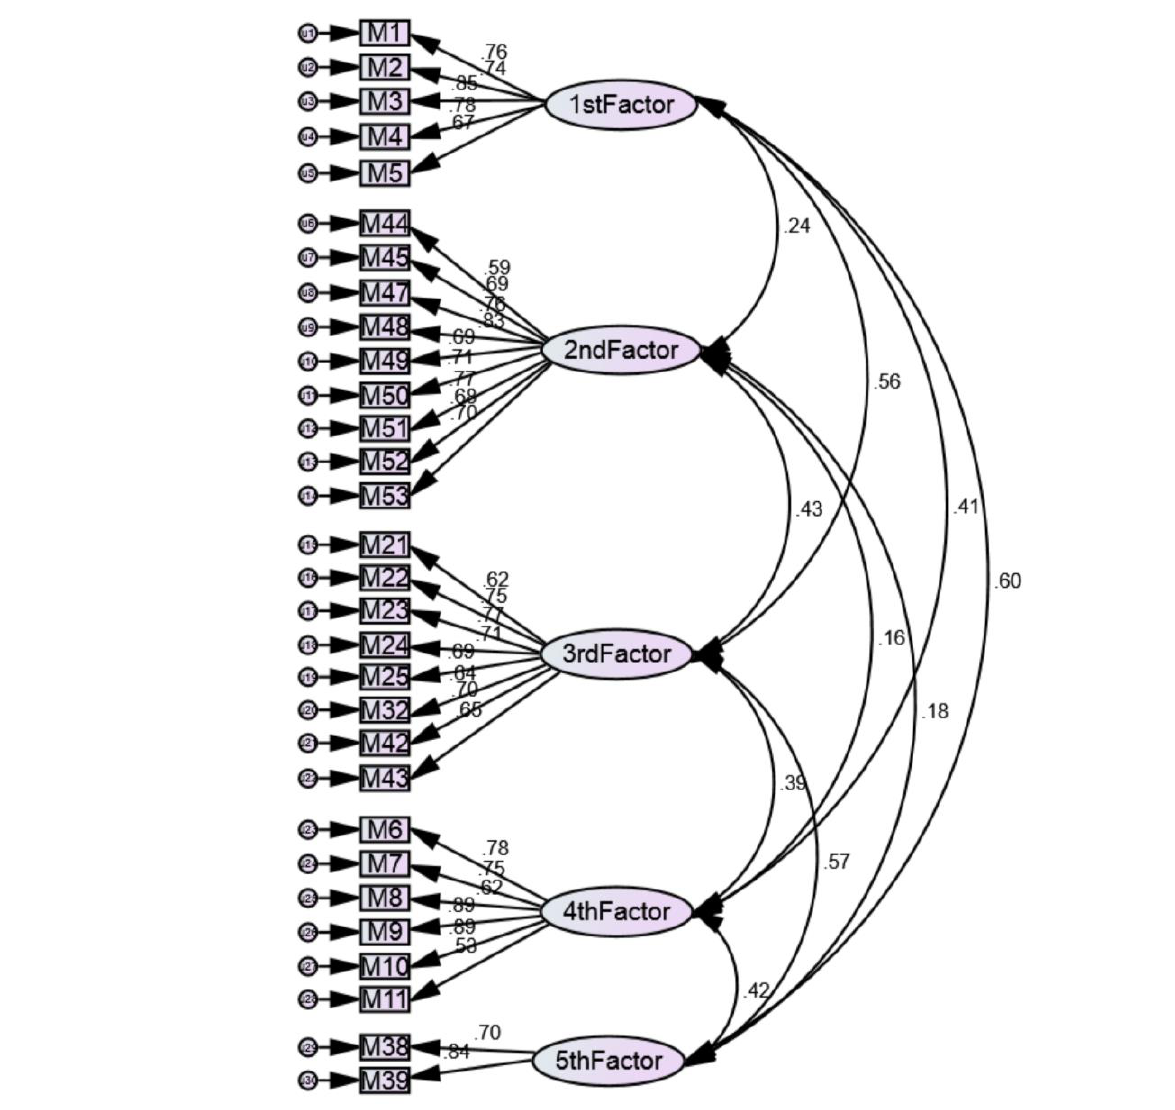
Figure 2. Measurement of self-regulated